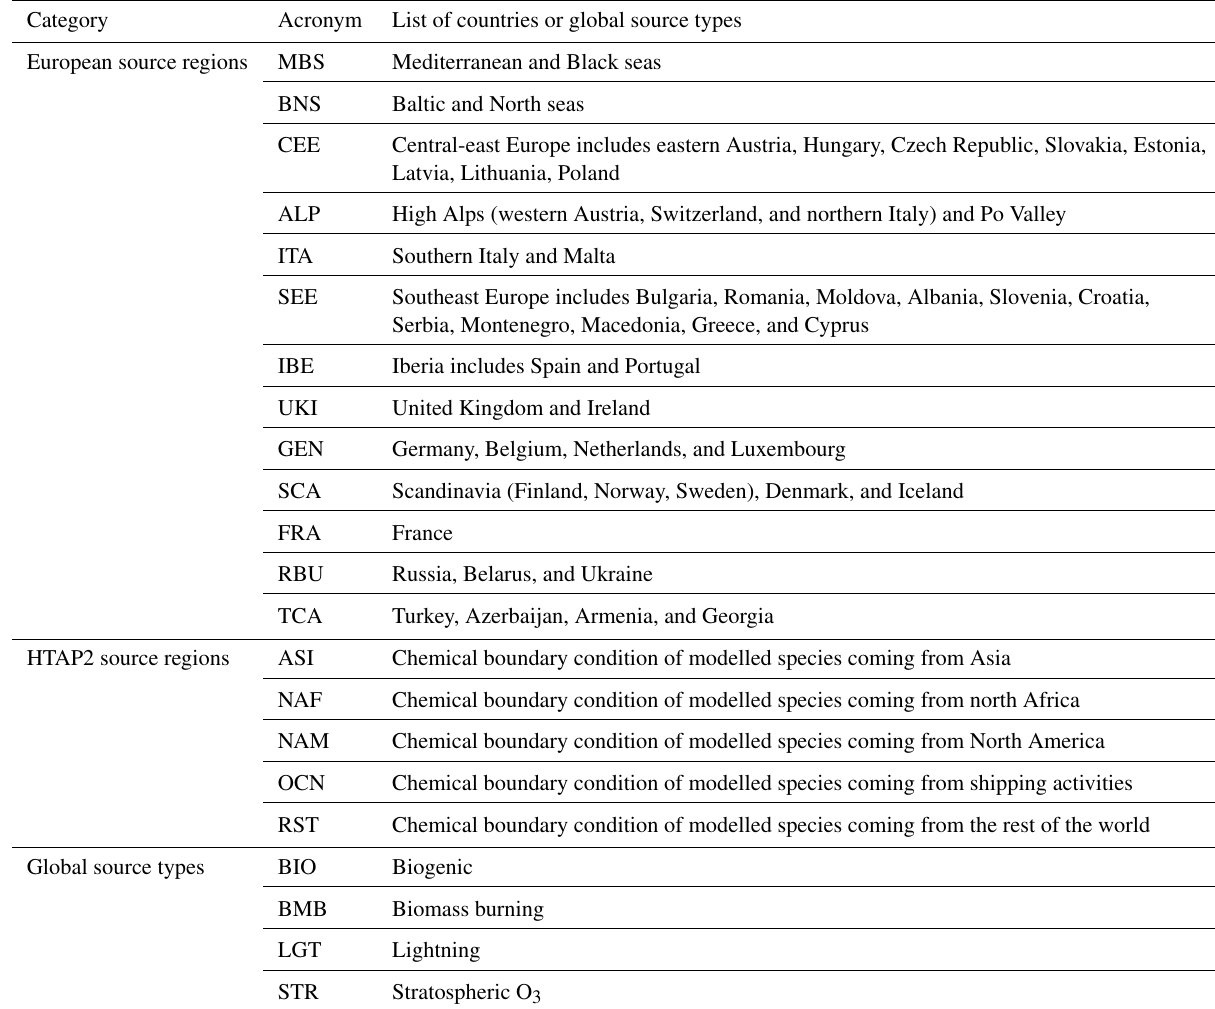
Table 1. List of tagged source regions and global source types.